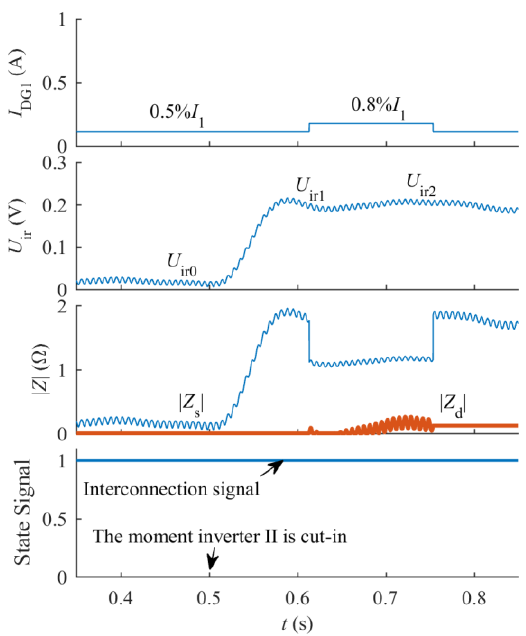
Figure 9. DG unit cut-in event occurring.